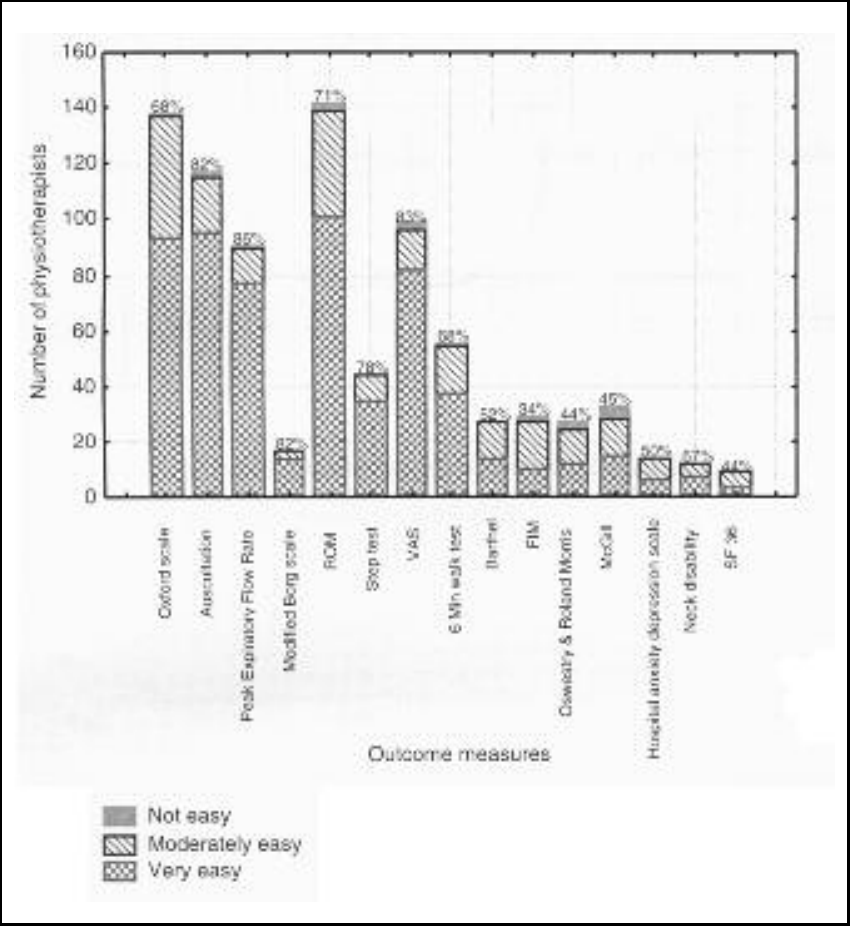
Figure 2: Response regarding ease of use of OM’s amongst SA physiotherapists (Multiple responses permitted)